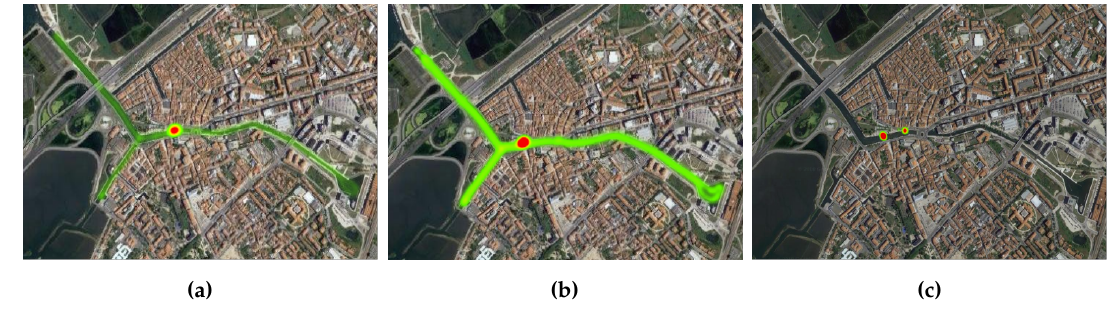
Figure 11. Moliceiro flow over day 2—Contacts-based Controlled Replication with Neighborhood